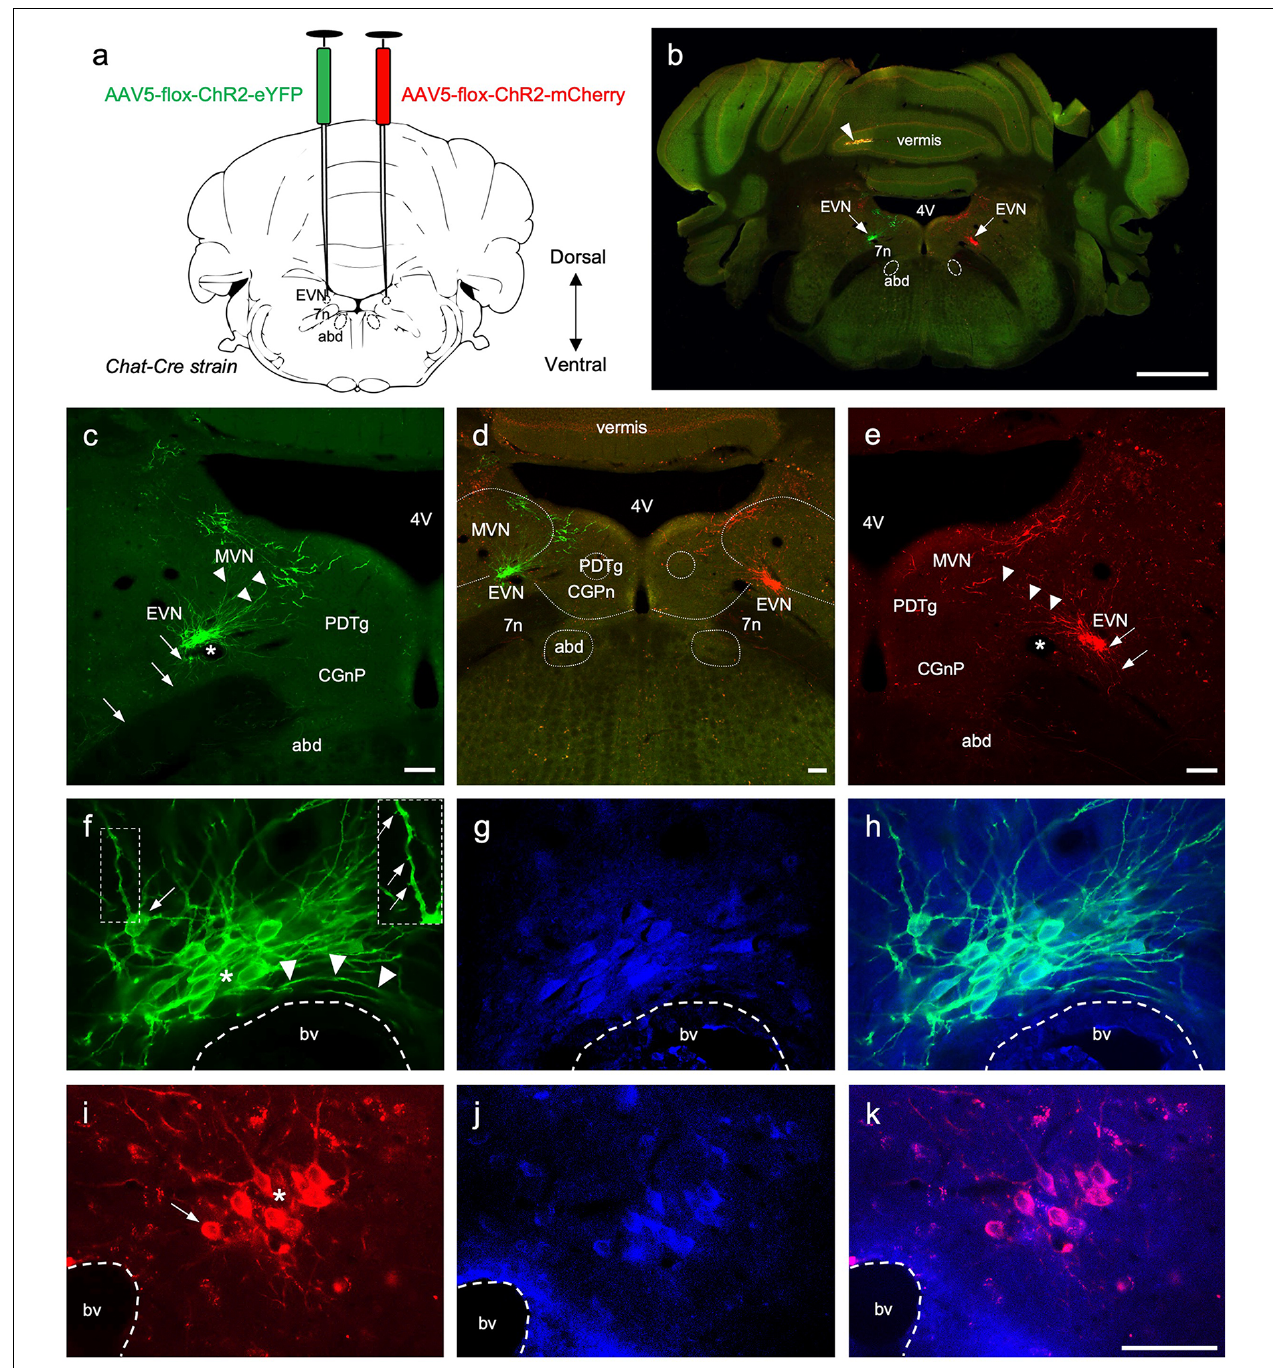
FIGURE 3 | The central components of the Efferent Vestibular System. (A) A schematic of a transverse section showing the double intracranial virus injection experiments in Chat-Cre strain. AAV5-flox-ChR2-eYFP virus was injected in the left Efferent Vestibular Nucleus, EVN (green), and AAV5-flox-ChR2-mCherry virus were injected in the right EVN (red). 7n—genu of the facial nerve, abd—abducens nucleus. (B) Photo-merged image of brainstem transverse section at the level of the EVN following adenovirus injection. The right side of the cerebellum was purposely nicked, prior to sectioning, to help orient sections when mounting. Arrows point at the viral-induced expression of EYFP (green) on the left, and mCherry (red) on the right. 4V—4th ventricle, arrowhead—yellow fluorescent signal in the cerebellar vermis. Scale bar: 1 mm. (C–E) Left panel, EVN (green channel), middle panel composite image (red and green channels), and right panel EVN (red channel). Both EVNs show extensive dorsomedial branching towards neighboring brain regions, which include MVN—Medial Vestibular Nucleus, PDTg—posterodorsal tegmental nucleus, CGPn—central gray of the pons. Arrows indicate descending axonal projections; arrowheads indicate dendritic